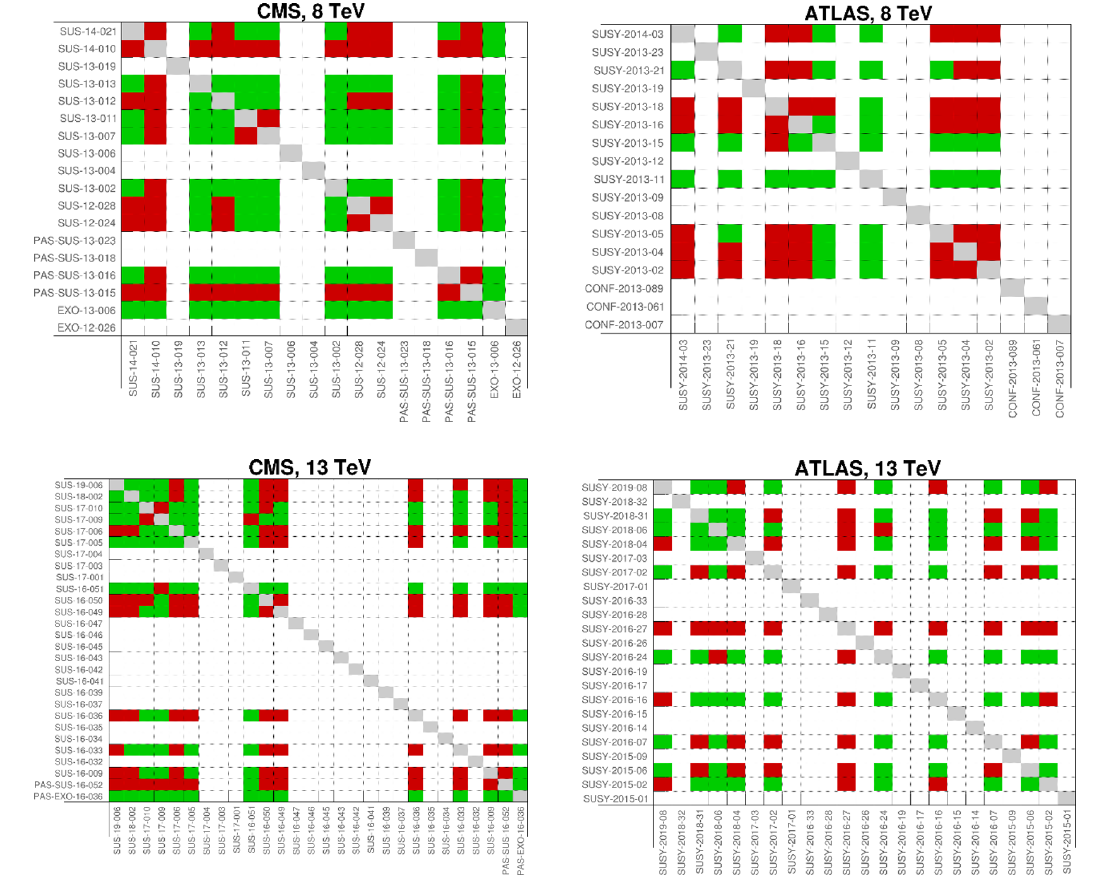
Figure 2 . Binary correlation matrices used in this work, describing which analyses are considered to be approximately uncorrelated (green bins) and which are not (red bins). Analyses from different LHC runs or different experiments are always taken as uncorrelated. White bins denote analyses, for which no likelihood can be computed (observed UL